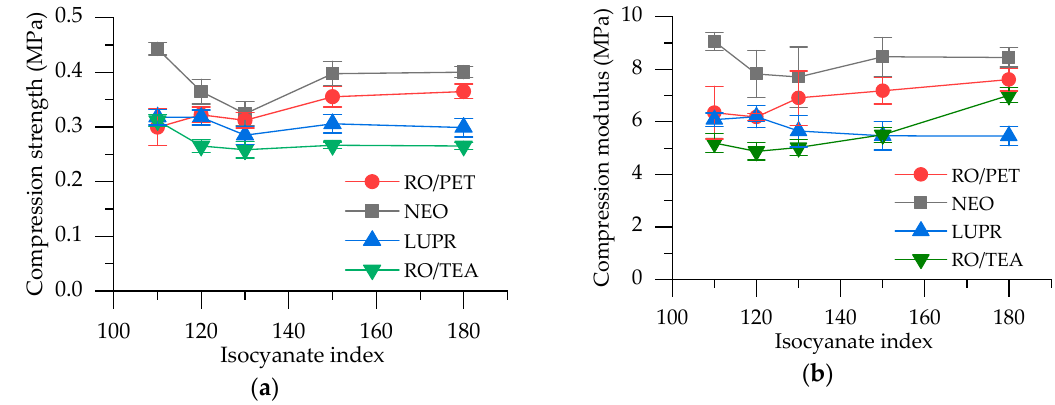
Figure 4. Physical-mechanical properties: ( a ) The compression strength of the RO / PET and reference rigid PUR foams; ( b ) Compression modulus of the RO / PET and reference rigid PUR foams.